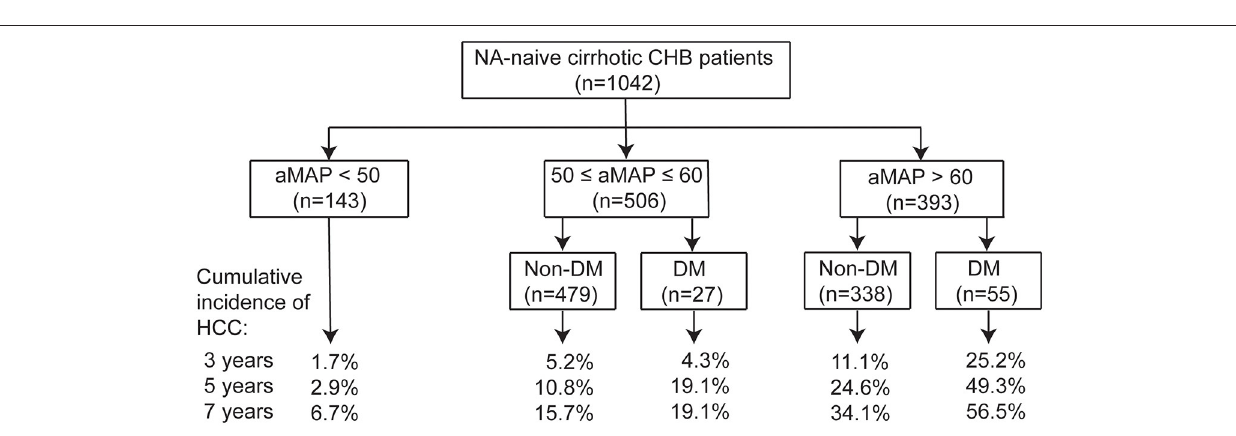
cirrhosis receiving ETV or TDF therapy, reduced potential confounding